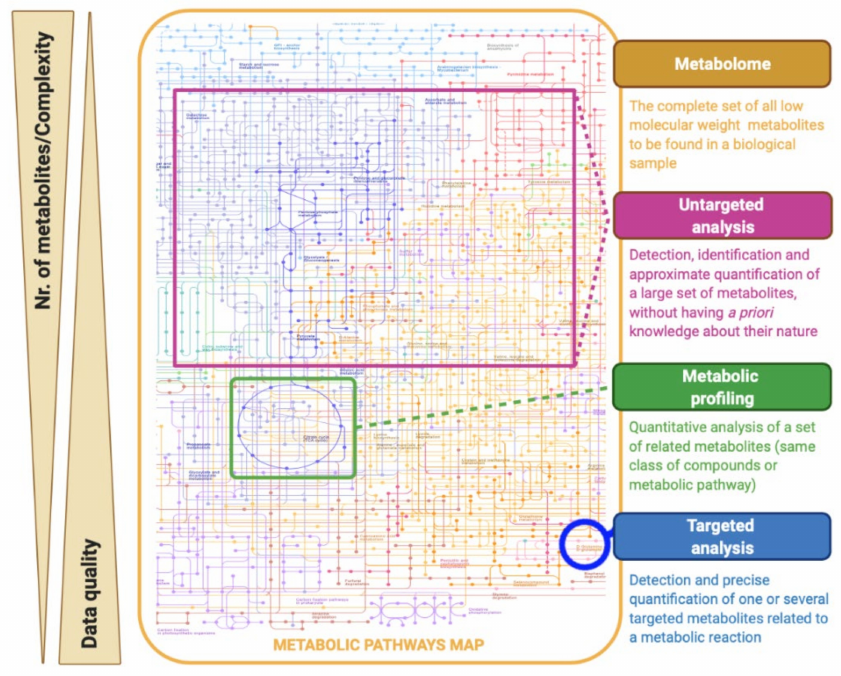
Figure 2. Classification of different strategies of metabolomic experiments (adapted from